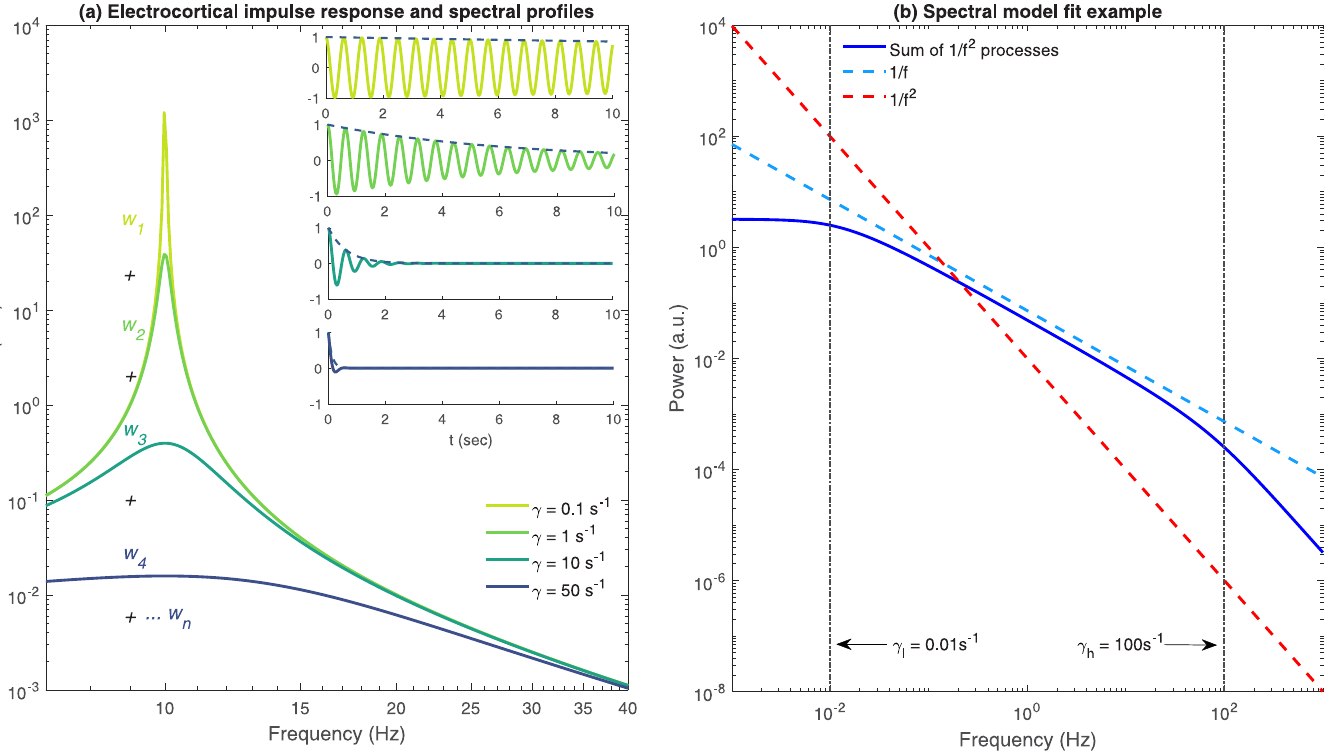
Fig 1. Resting EEG as a sum of damped independent alpha oscillatory processes. (a) Power spectral density of the model electrocortical impulse response cos(2 πf α t ) exp( − γ t ) Θ ( t )for γ = {0.1, 1, 10, 50} s − 1 , where Θ ( t ) is the Heaviside step function. Resting EEG is modeled as a continuous sum of such processes over some suitable interval of dampings [ γ l , γ h ]. In general we aim to find the appropriate weights { w i } that account for the shape of the resting EEG power spectrum. (b) A 1/ f spectrum (dashed blue) can be approximated as a sum of 1/ f 2 relaxation processes (solid blue) that are uniformly distributed in damping over some interval which for the displayed case is [ γ l = 10 − 2 , γ h = 10 2 ] s − 1 . For clarity we have assumed f α = 0 Hz.